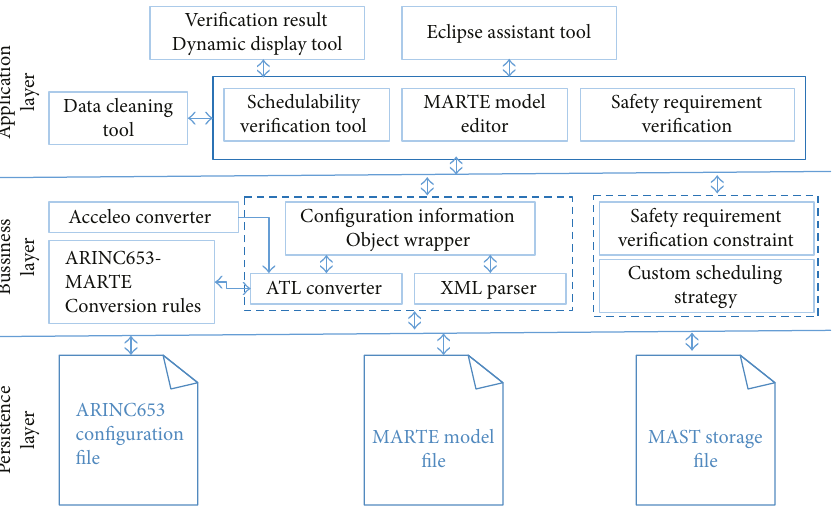
Figure 17: Architecture of prototype tool CC653.